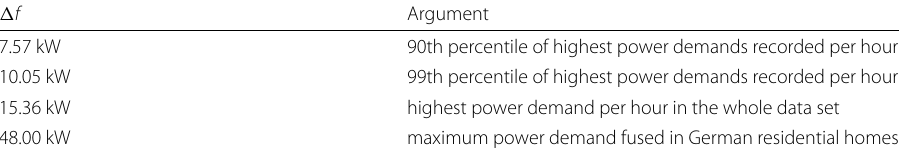
Table 2 Selected (cid:5) f and according reasoning based on (Smart Metering Project - Electricity Customer Behaviour Trial